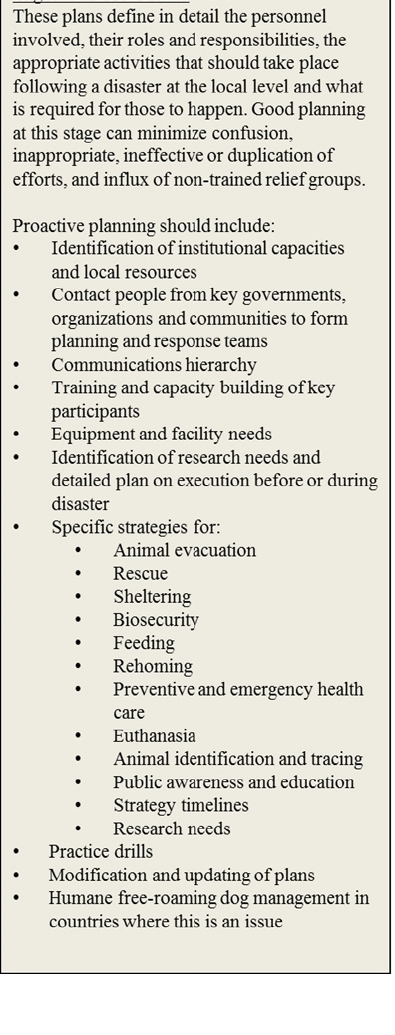
Figure 2. Description of the objectives of regional and local preparedness plans with examples of potential